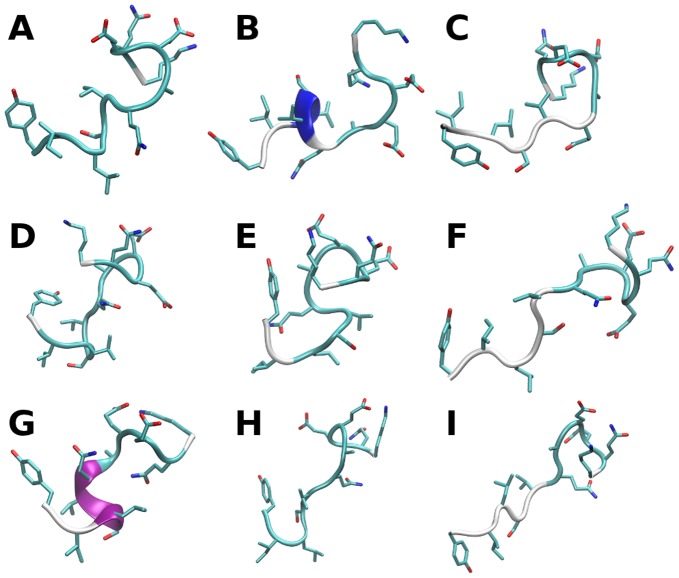
Representative conformations from the computed equilibrium ensemble for apo c-Myc402–412.The conformations depicted are those closest to the center of the most populated clusters. The fractional cluster populations are: 0.101±0.018 (A), 0.075±0.034 (B), 0.060±0.040 (C), 0.059±0.027 (D), 0.055±0.016 (E), 0.043±0.004 (F), 0.030±0.017 (G), 0.021±0.009 (H), 0.021±0.003 (I). Figure prepared with the software VMD [78].